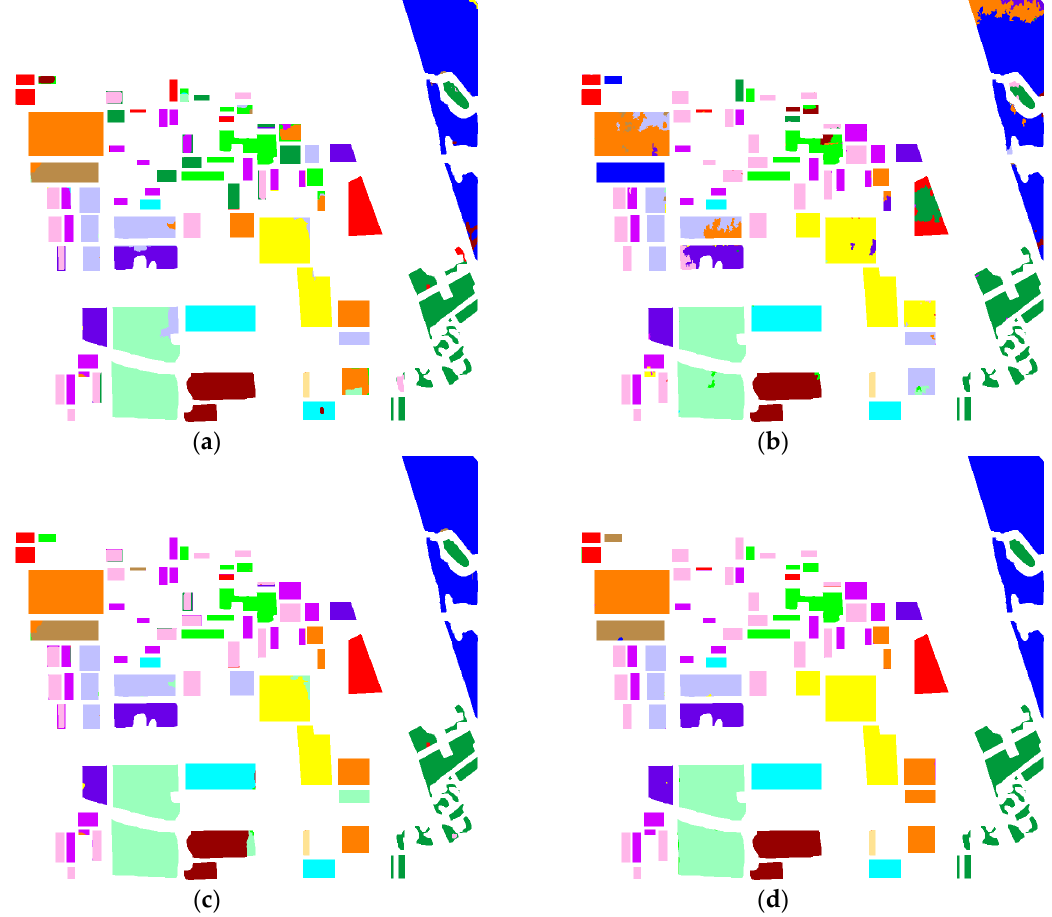
Figure 6. Classification results obtained for the AIRSAR imagery with the different classification algorithms: ( a ) KNN classifier; ( b ) Wishart classifier; ( c ) LOR-LBP classifier; ( d ) RF classifier.